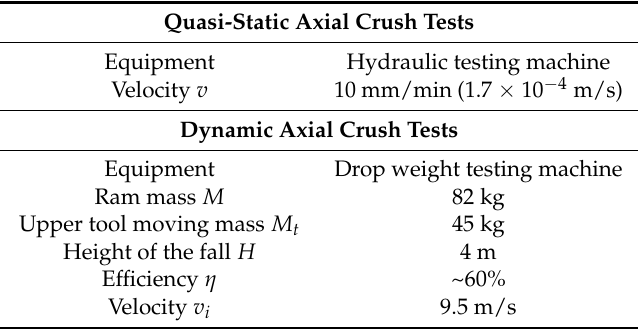
Table 3. Summary of the quasi-static and dynamic axial crush testing